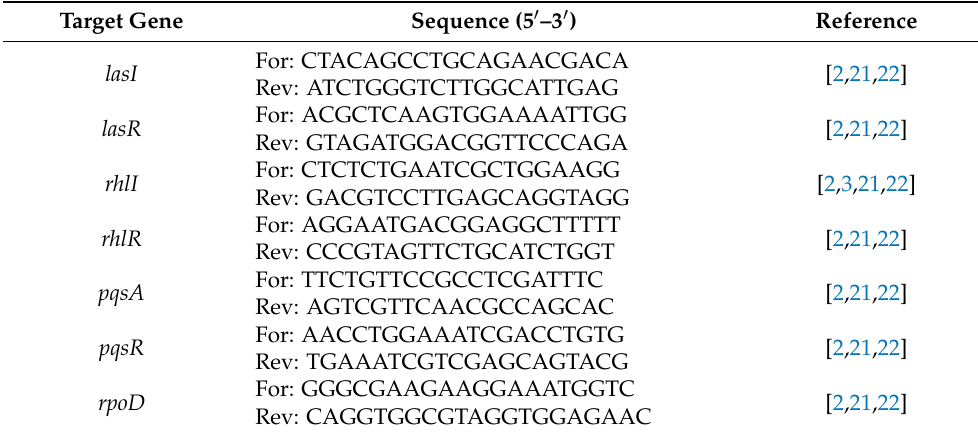
Table 1. Sequences of the primers used in this